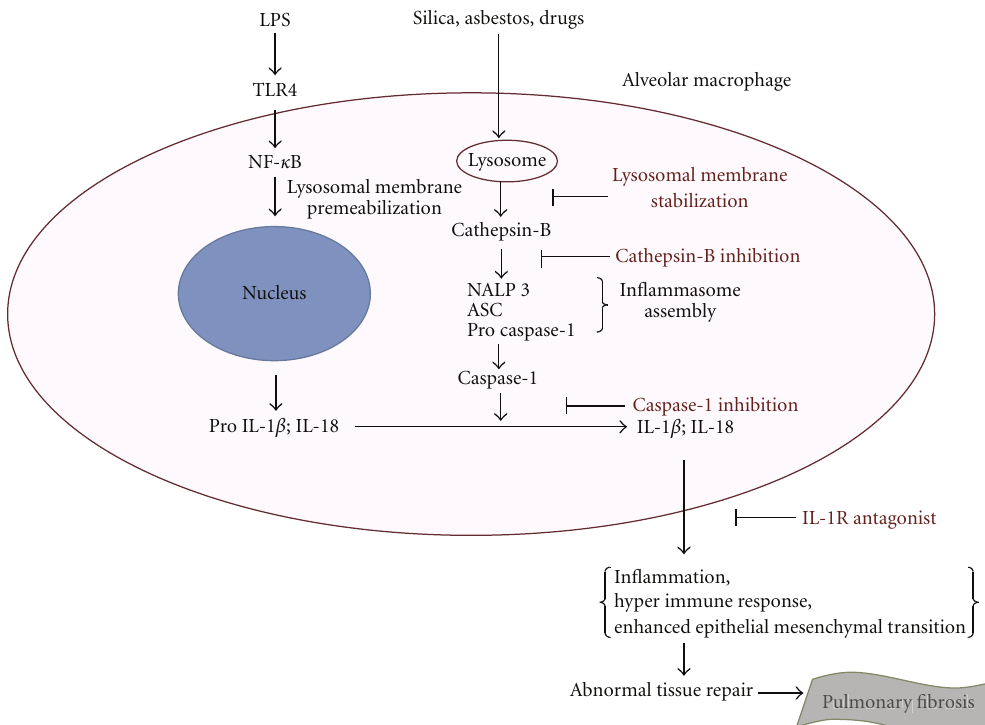
Figure 2: Potential inflammasome targets for novel PF therapeutics. Lysosomal membrane permeabilization plays an important role in cathepsin B release and inflammasome activation. Therefore, stabilization of the lysosomal membrane would prevent initiation of the adverse events associated with inflammasome activation. Similarly, inhibition of cathepsin B would attenuate inflammasome assembly and activation. Further downstream of inflammasome assembly, inhibition of caspase -1, would prevent maturation of proinflammatory cytokines such as IL-1 β and IL-18. In addition, IL- 1R antagonists would prevent the downstream events following the binding of IL-1 β to its